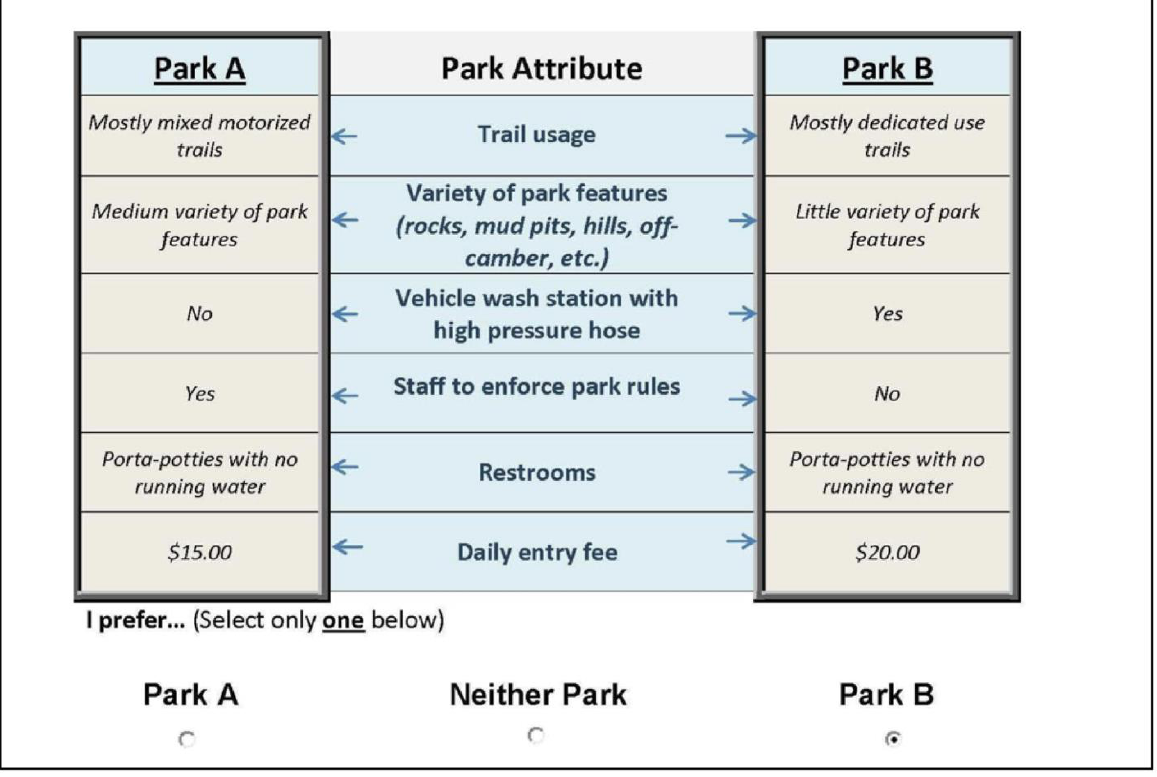
Figure 4. Sample choice set.